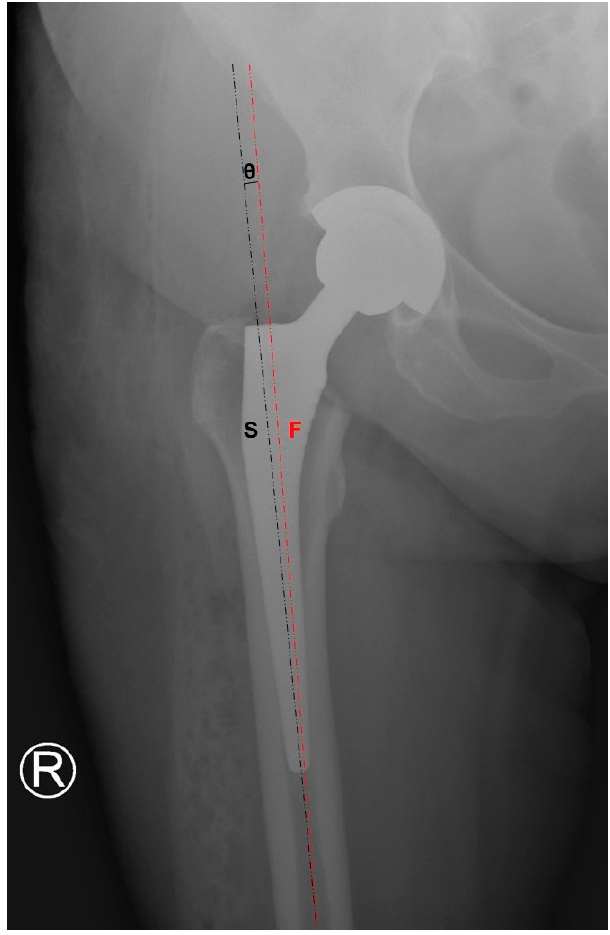
Figure 2. Femoral stem alignment measurement.